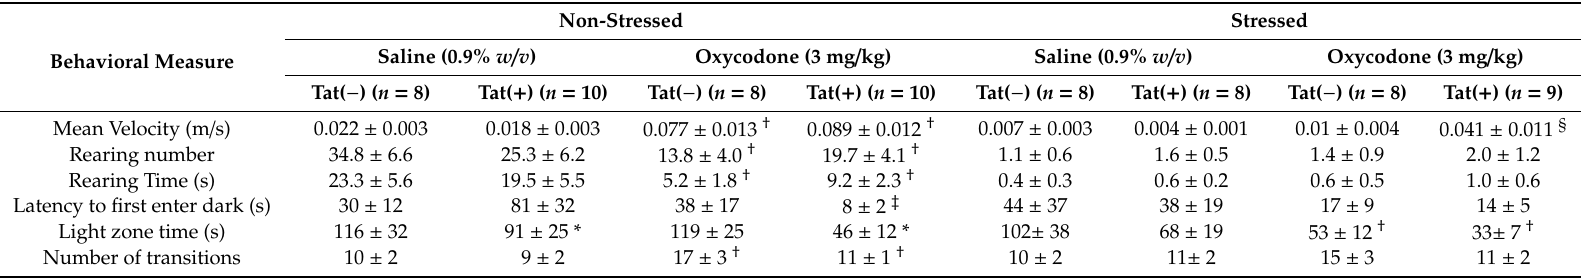
Table 2. Motor measures acquired in an open field and anxiety-like / motor measures acquired in a light-dark transition task from Tat( − ) and Tat( + ) males that were exposed (or not) to a 15-min forced swim stress with repeated administration of saline or oxycodone. * indicates a main e ff ect of genotype wherein Tat( + ) mice di ff er from Tat( − ) controls. † indicates a main e ff ect for oxycodone to di ff er from saline-administered mice. ‡ indicates an interaction wherein the denoted group significantly di ff ers from Tat( + ), saline-administered controls. § indicates an interaction wherein the denoted group significantly di ff ers from all other groups, p ≤